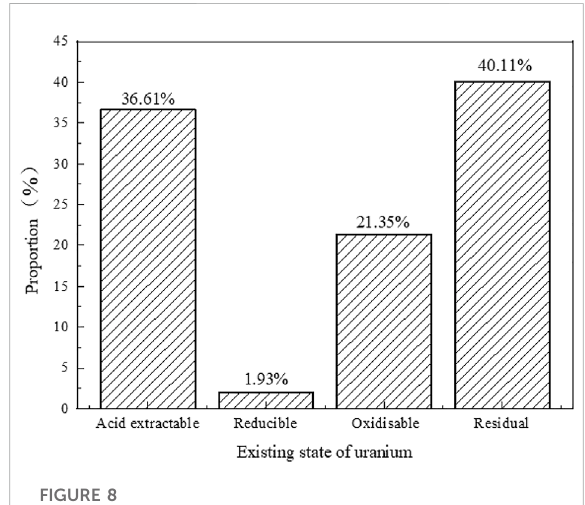
FIGURE 8 Speciation distribution of uranium in uranium